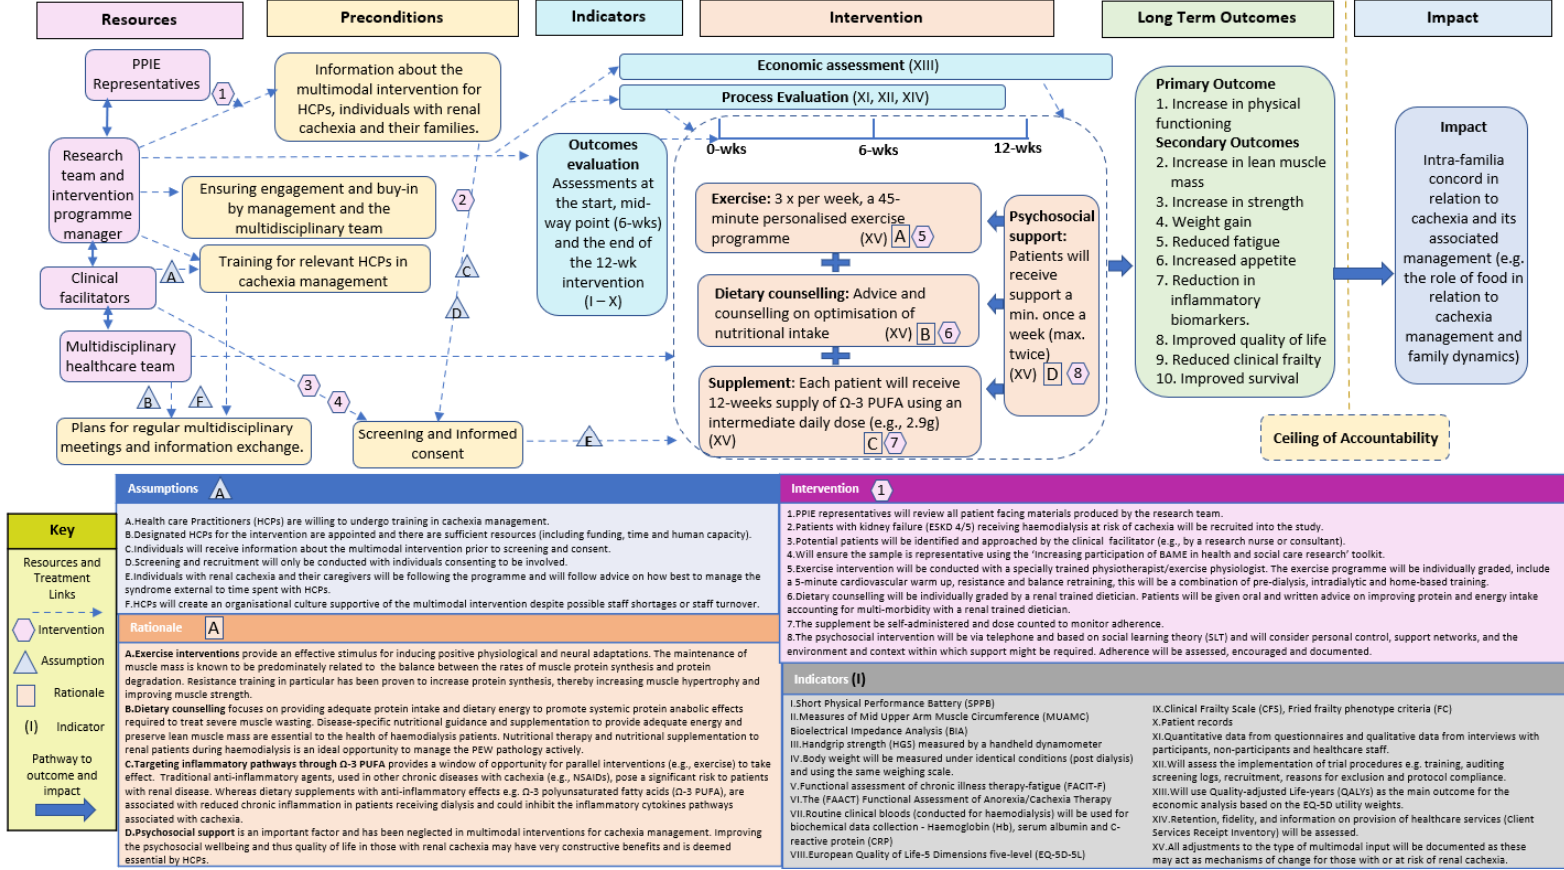
Figure 1. ToC Map.